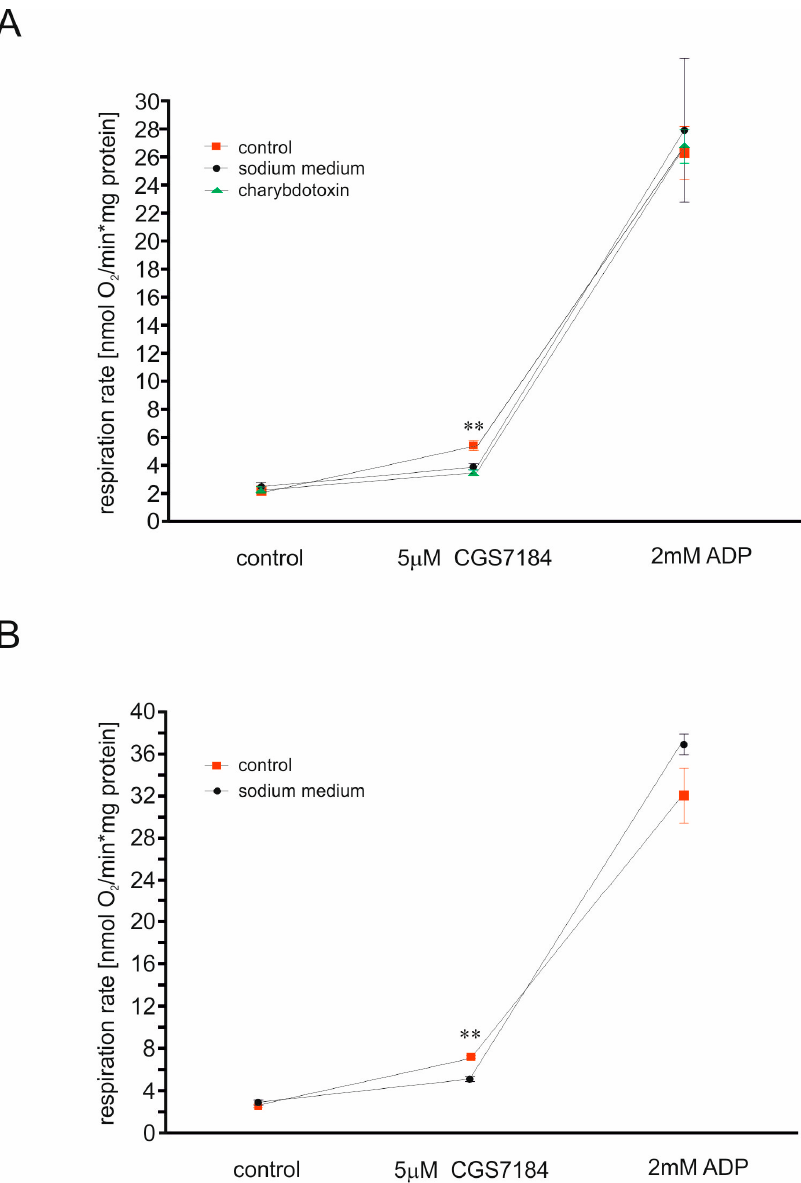
Figure 2. Potassium channel opener CGS7184 stimulates mitochondrial respiration via mitoBK Ca